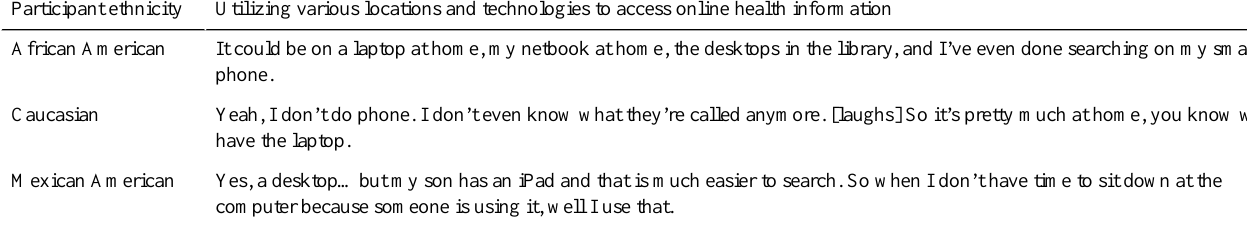
Utilizing various locations and technologies to access online health informationParticipant ethnicity